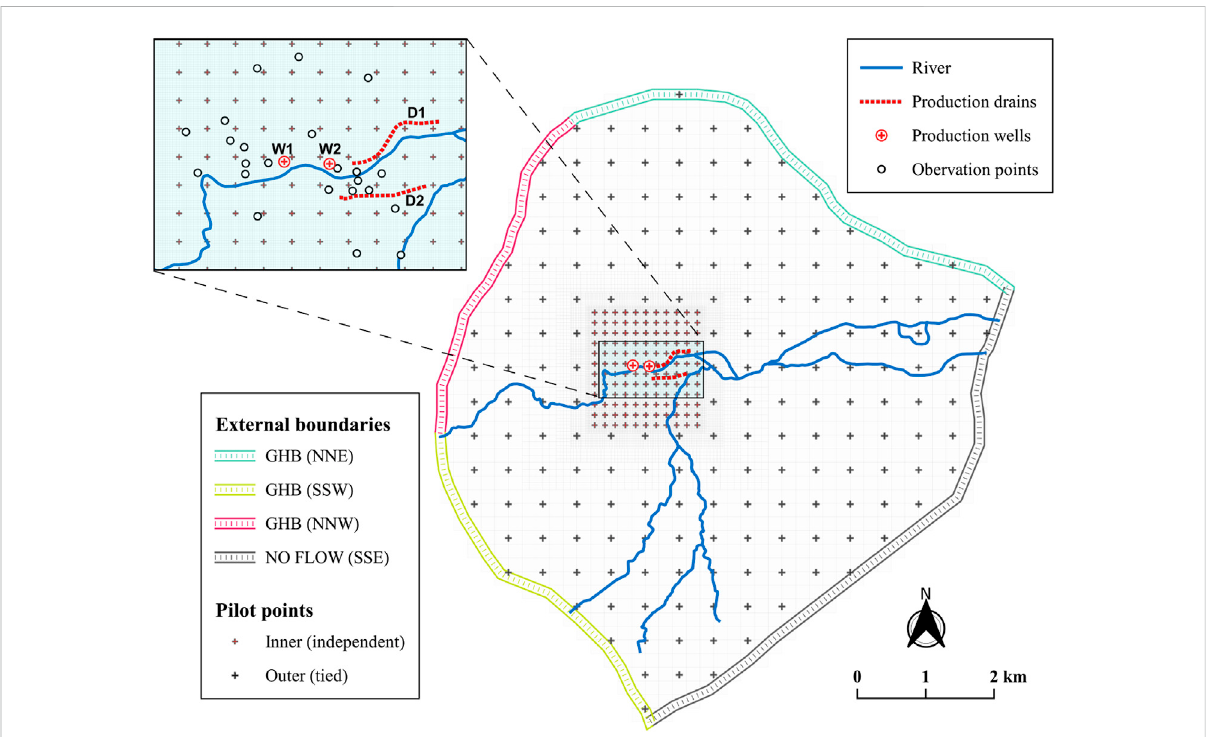
FIGURE 6 Model domain with boundary conditions inferred from the regional groundwater fl ows. Mesh re fi nement is conducted in the area of interest around the production and observation wells and drains (see inset). The parameterization of hydraulic conductivity has been conducted with pilot